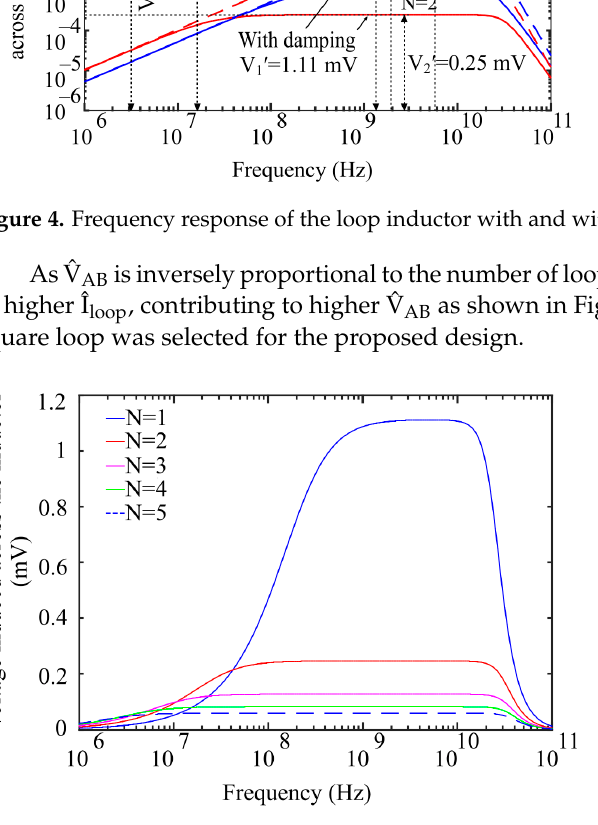
Figure 5. Voltage generated across the loop inductor as a function of number of loop turns N . As the loop current ˆI loop depends on A loop / L loop ratio, for a fixed loop area A loop